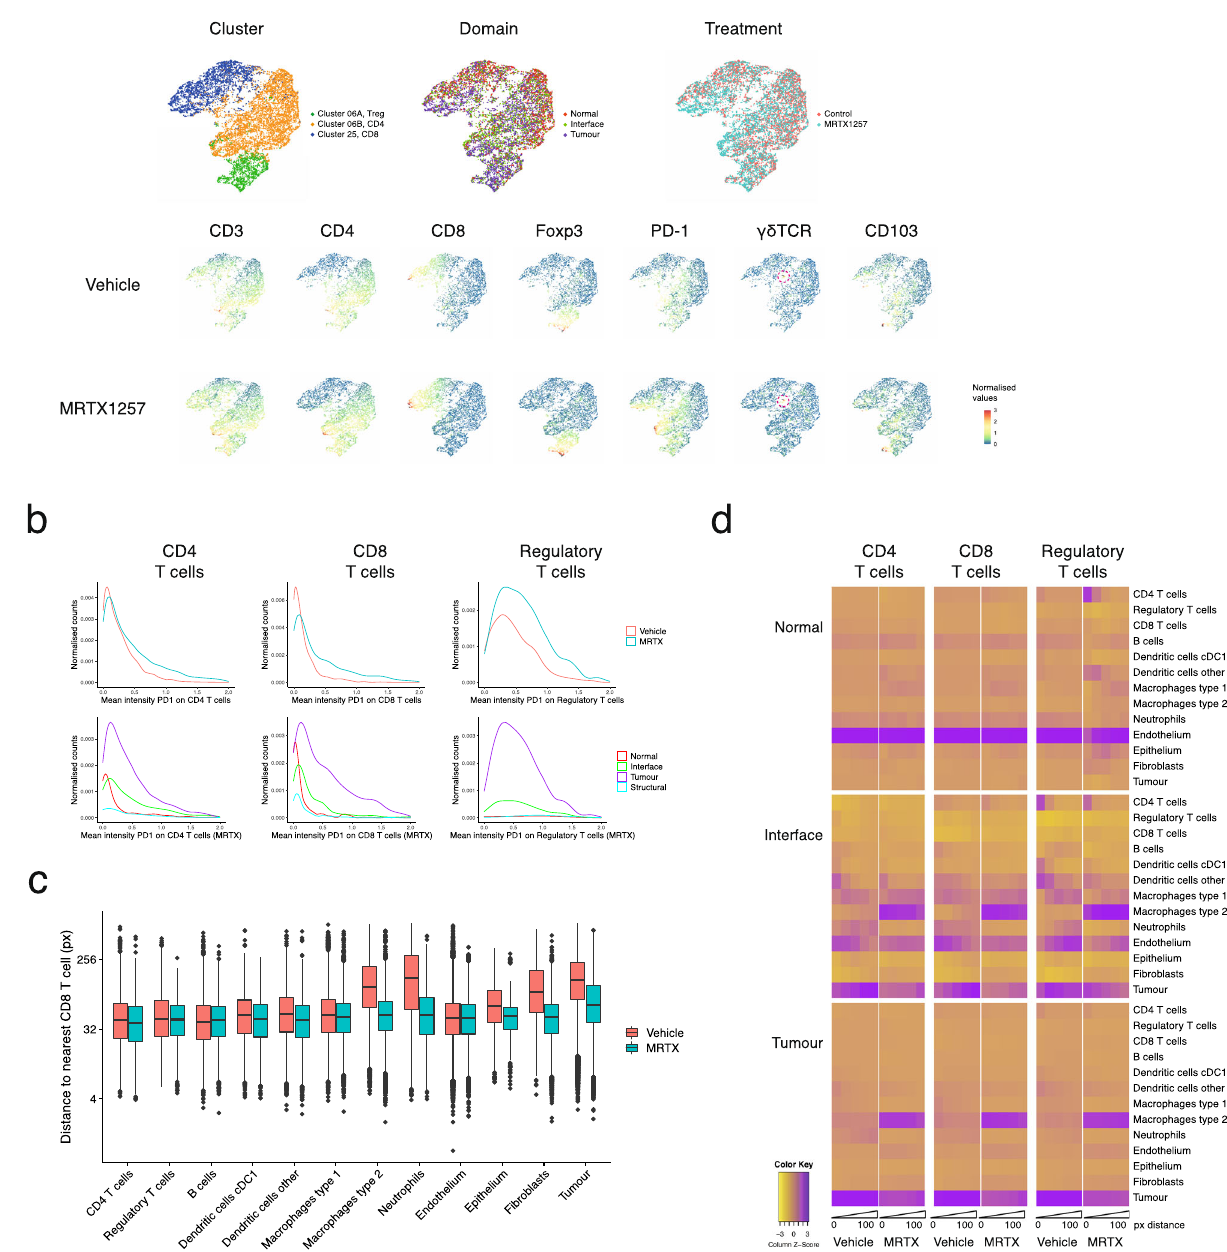
Fig. 5 Phenotypic and spatial characterisation of T cells in response to treatment. a uMAP of T cell clusters (top left), coloured by tissue domain (top middle), treatment (top right) and the expression of individual markers that were selected for the generation of these uMAPs in the bottom two rows, data separated by treatment group. b T cells upregulate PD-1 upon MRTX1257 treatment, but only those within the tumour domain. Histograms plotting the normalised counts for the mean intensity of PD-1 per CD4 + CD8 + or regulatory T cell. Top: data separated by treatment, bottom: MRTX1257 treated samples only, separated by tissue domain. c Box-and-whiskers plot depicting the distance of cell types to the nearest CD8 + T cell. In vehicle-treated tumours, CD8 + T cells are on average found in the proximity of other lymphocytes, endothelium, DCs and Type 1 macrophages, but not close to tumour, fi broblasts or Type 2 macrophages. Upon MRTX1257 treatment, these distances generally become shorter, re fl ective of migration of CD8 + T cells into the tumour domain accompanied by an increased presence of Type 2 macrophages and fi broblasts within the tumour. Boxes minima and maxima represent 25th and 75th percentile, centre depicts the median, whiskers indicate 1.5× interquartile range, dots are individual outliers. Linear mixed-effects modelling con fi rmed that between treatments the cell types display a signi fi cantly different distribution of distances to a nearest CD8 T cell ( P value = 0.0001 for treatment:cell type interaction, ANOVA tested). d Heatmaps for the different domains displaying cells in close proximity to the cell type of interest, separated by treatment and binned in distances from the centre of the cell (bins: 0 – 20px, 20 – 40px, 40 – 60px, 60 – 80px and 80 – 100px). Scaled on columns to show the relative contribution of cell types to the neighbourhood. MRTX MRTX1257, px pixels.